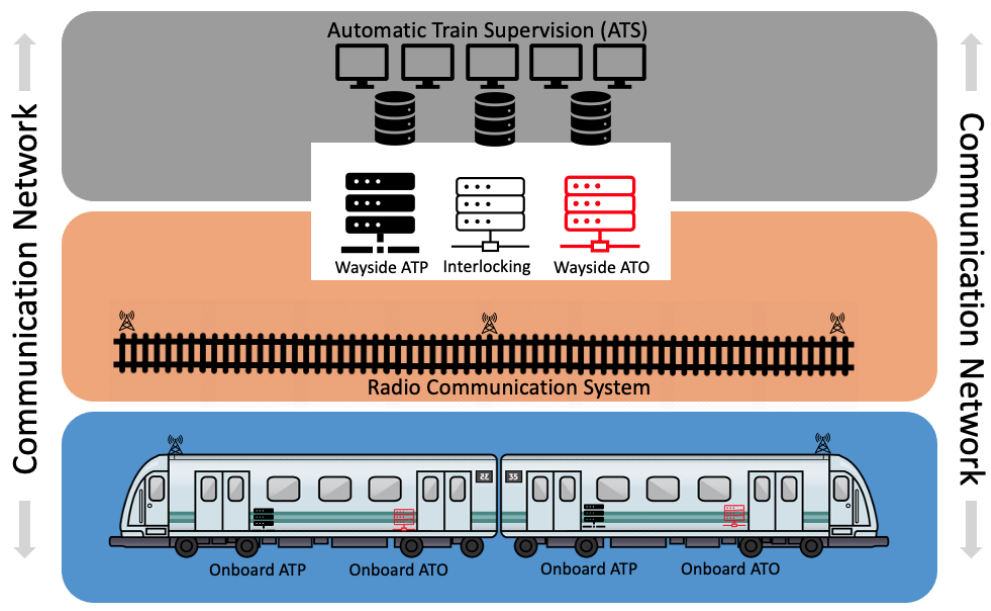
Figure 1. Communications-Based Train Control (CBTC) system